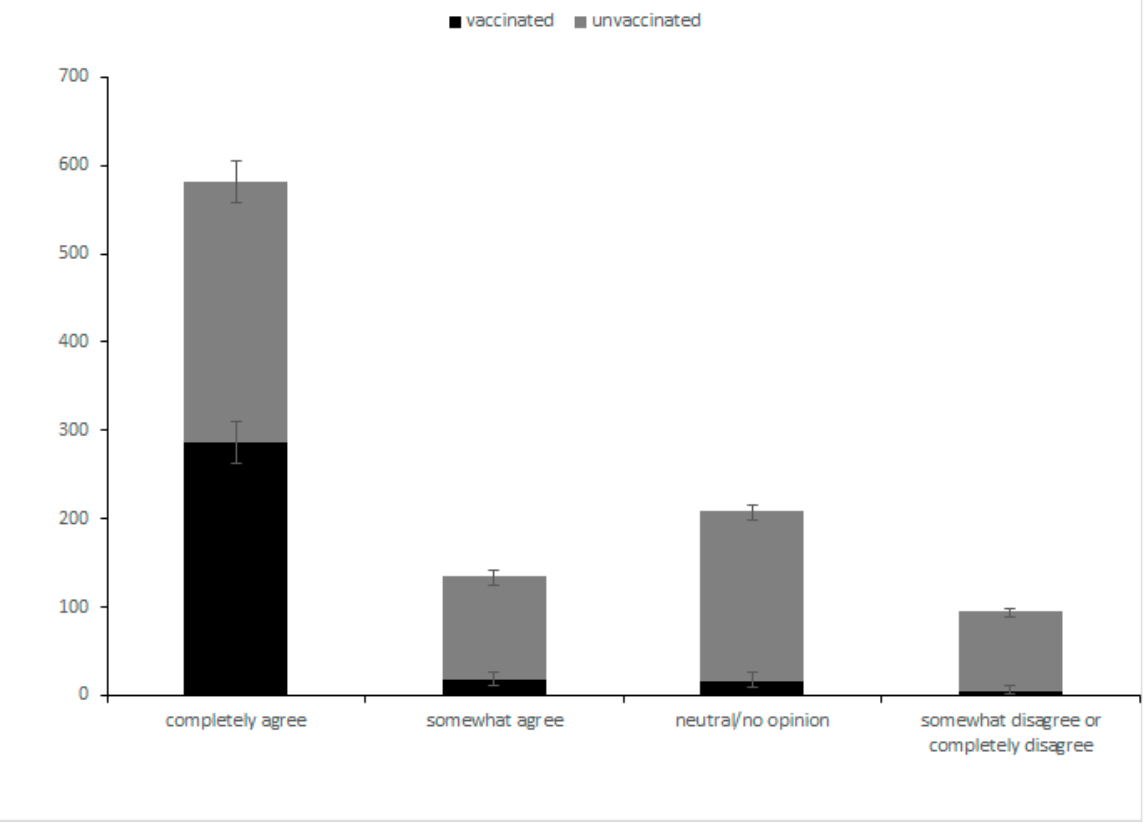
Figure 1. Attitudes toward the COVID-19 vaccination and the vaccination rate. Table 2. Logistic regression analysis of attitudes toward COVID-19